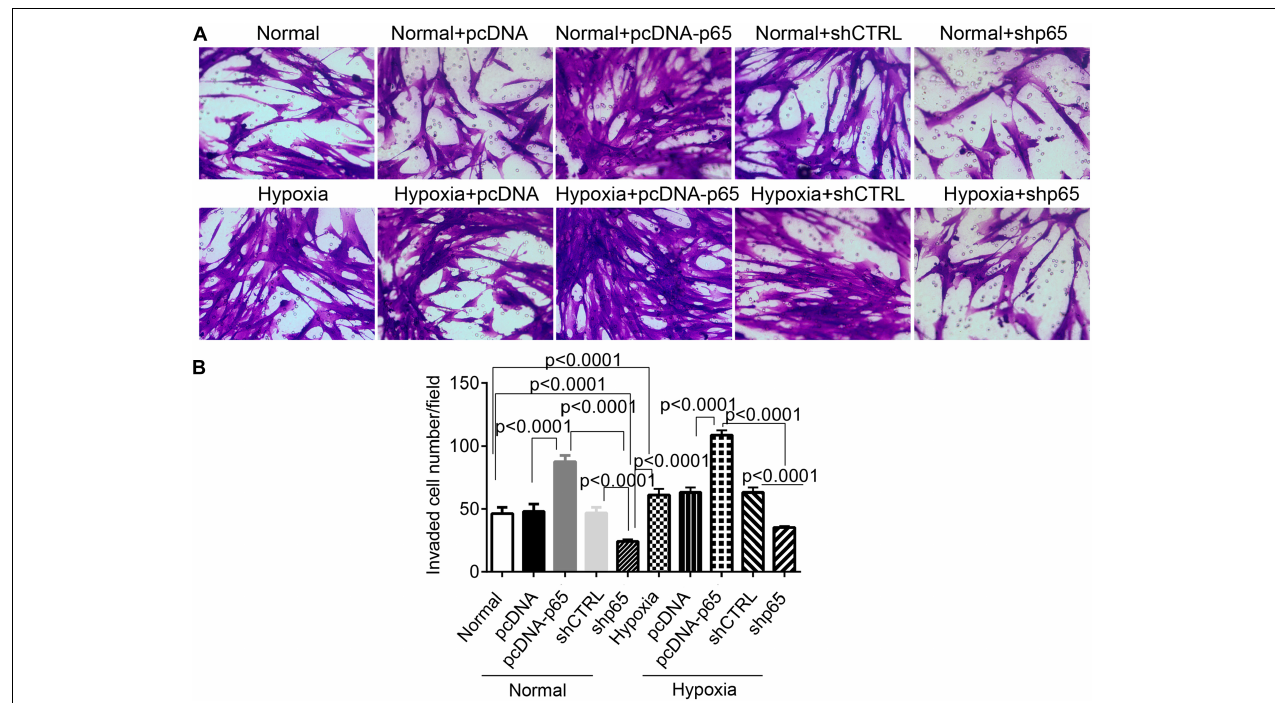
FIGURE 3 | The invasion ability of hPASMCs in response to p65 expression and hypoxia treatment. (A) The representative images of the invaded hPASMCs following pcDNA-p65, shp65, and hypoxia treatments. (B) The statistical analysis of the invaded cells. The differences were analyzed using one-way ANOVA. CTRL, control.